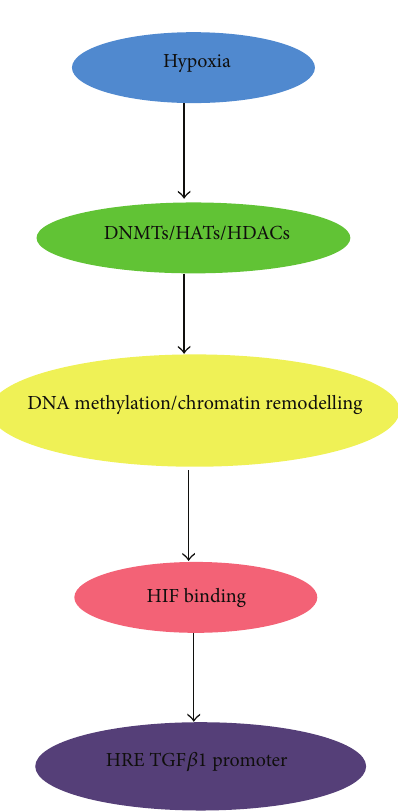
Figure 5: Epigenetic changes allow HIF binding to HIF response elements (HREs). A hypoxic environment within a cell can cause normal epigenetic mechanisms to be changed, altering the level of DNA methylation and/or modifying chromatin conformation allowing HIF1 𝛼 to bind to the HRE on the gene [85]. The TGF 𝛽 1 promoter has been previously shown to contain a HRE [86], and so hypoxia can alter TGF 𝛽 1 expression through HIF1 𝛼